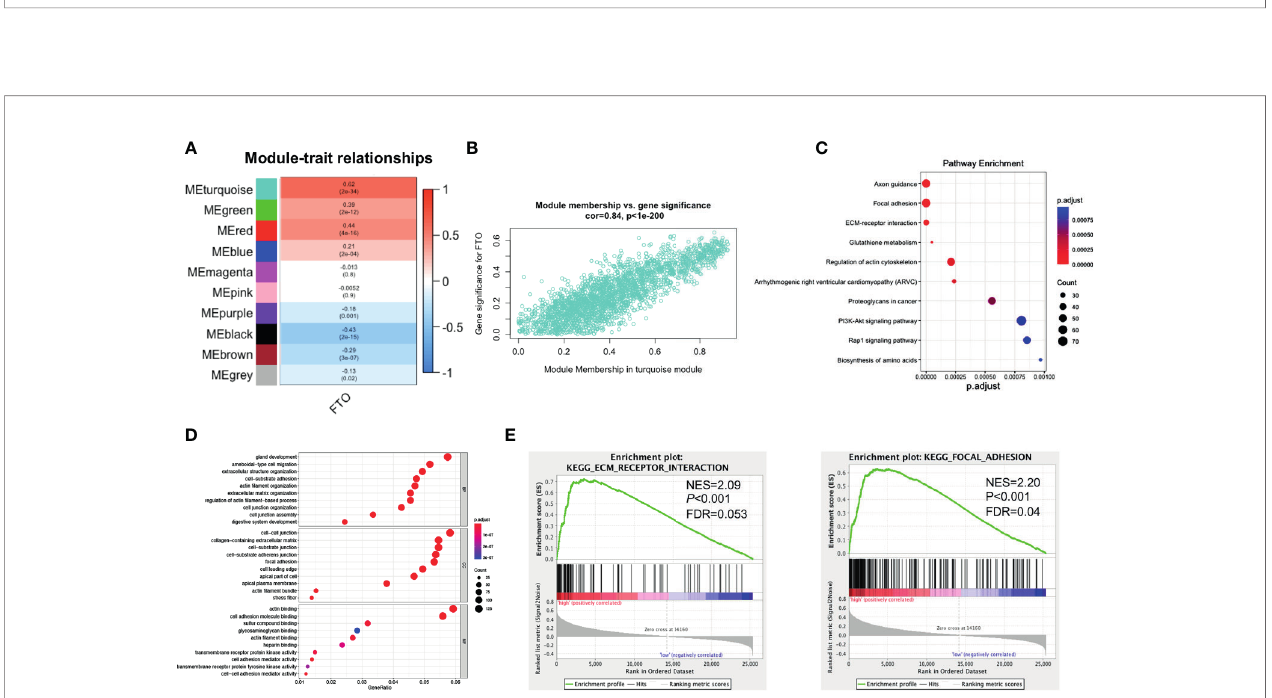
FIGURE 4 | Functional enrichment analysis of FTO-related key module. (A) Heat map of the correlation between module eigengenes (ME) and the expression level of FTO. The turquoise module was the most positively correlated with FTO high expression. (B) Scatter plot of the correlation between genes in turquoise module and the expression level of FTO. (C) Signi fi cantly enriched KEGG pathways of turquoise module. (D) Signi fi cantly enriched GO annotations of turquoise module. (E) FTO high expression group enriched signaling pathways were analyzed using